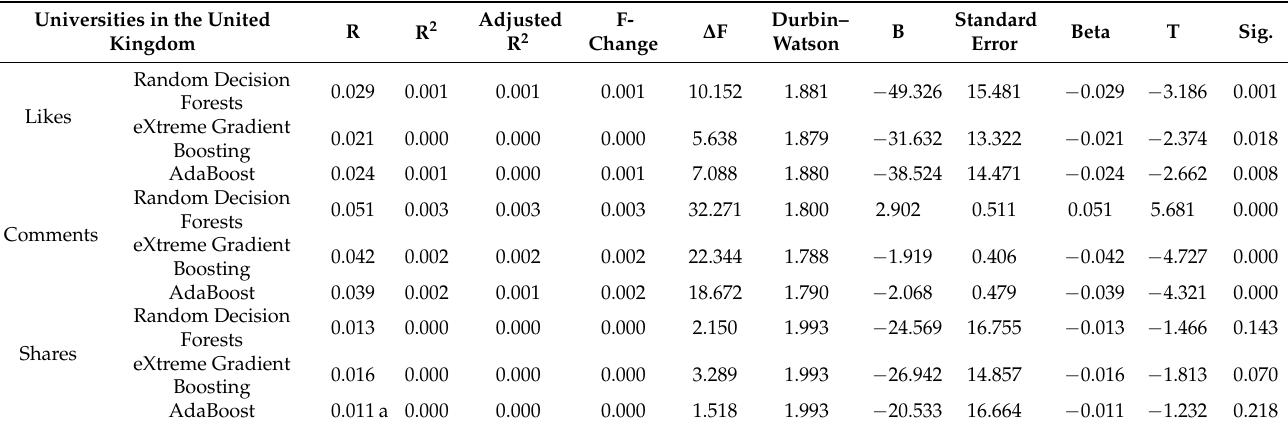
Table 3. Linear regression coefficient of determination and beta (universities in the United